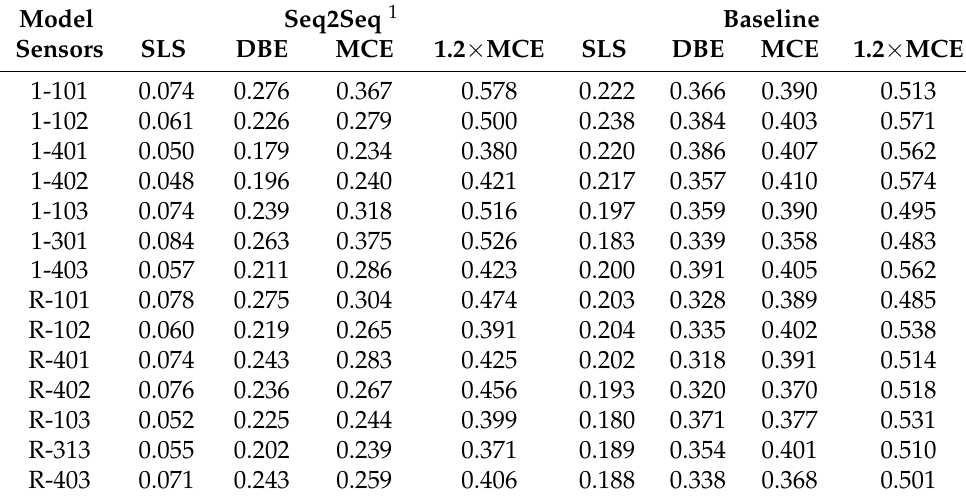
Table 3. Summary of probabilities of